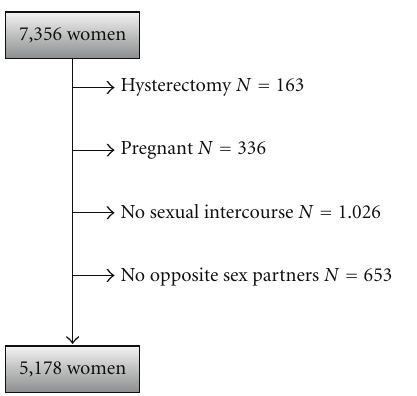
Figure 1: National Survey of Family Growth (2006–2008) Analytic